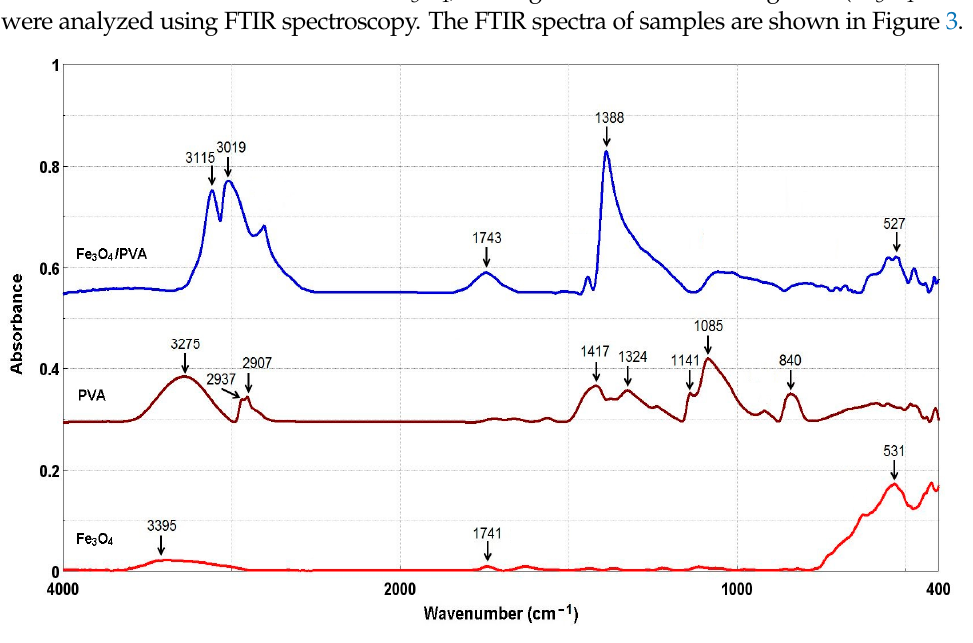
Figure 3. FTIR spectra of Fe 3 O 4 , PVA, and Fe 3 O 4 /PVA.